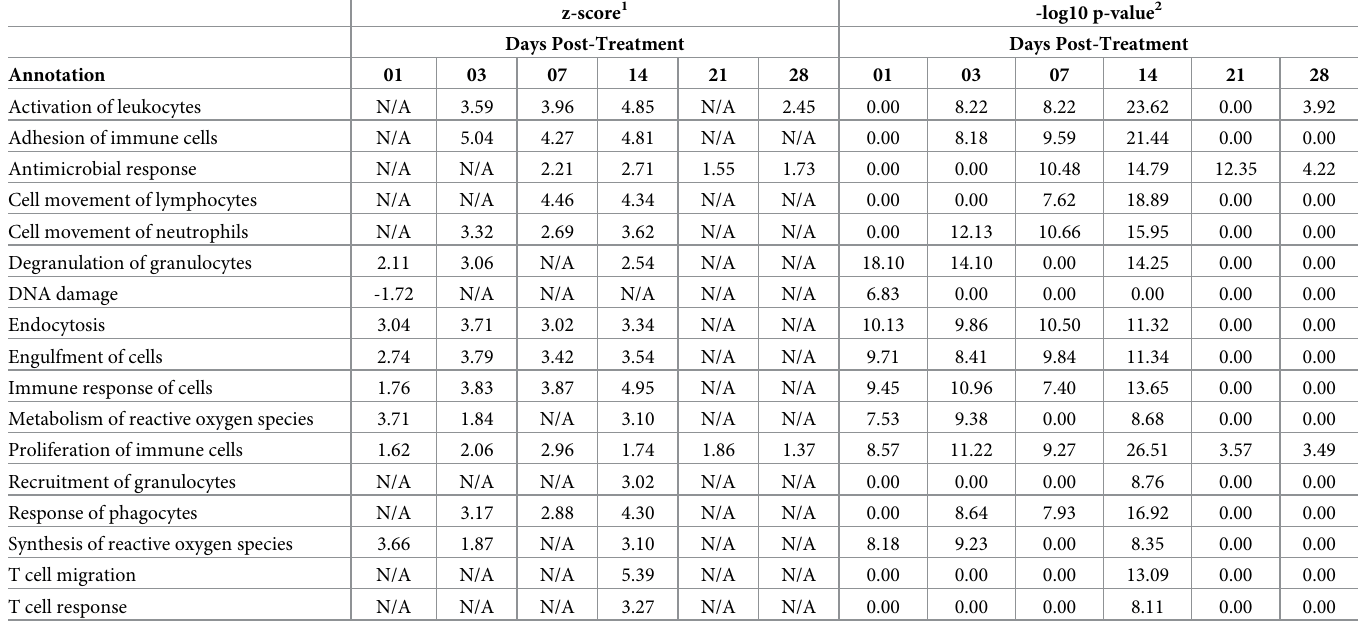
Table 2. Stress and immune response biological pathways associated with laser resurfacing kinetics.